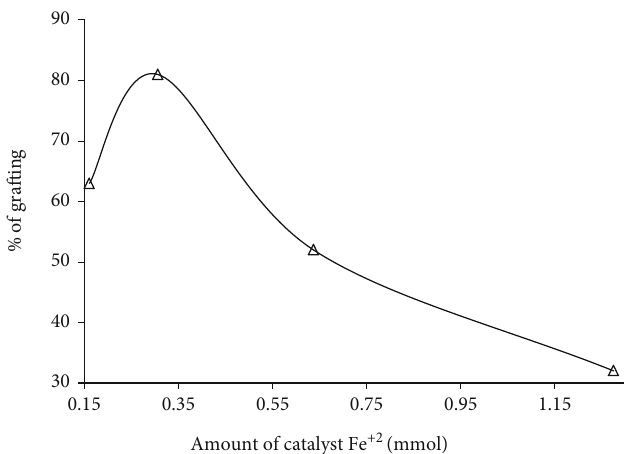
Figure 6: E ff ect of the amount of catalyst Fe +2 on the % of grafting. AN: 8 ml, H